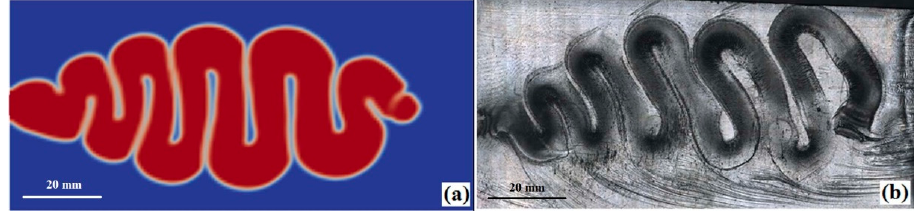
Figure 7. Comparison between simulated jetting ( a ) and experimental jetting ( b ) for the plate part molding.